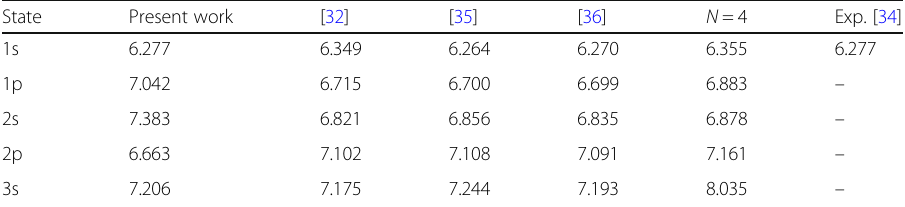
Table 3 Mass spectra of bc meson (in GeV) ( m b = 4.823 GeV, m c = 1.209 GeV, a = 0.606 GeV 2 , b